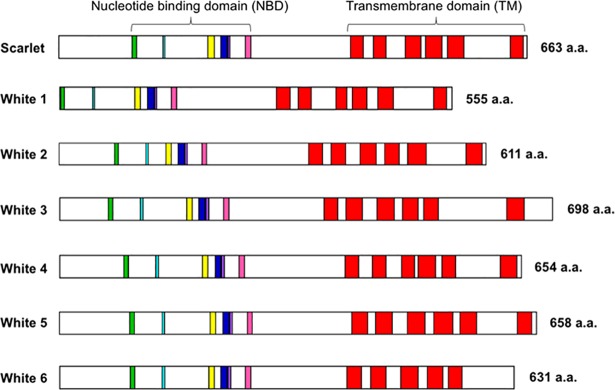
Putative structures of orthologs of eye transporter proteins in Daphnia magna.The green, light blue, yellow, dark blue, purple and pink boxes indicate the Walker A/P-loop, Q-loop, ABC signature motif, Walker B, D-loop, and Switch/H-loop. Red boxes show transmembrane regions.